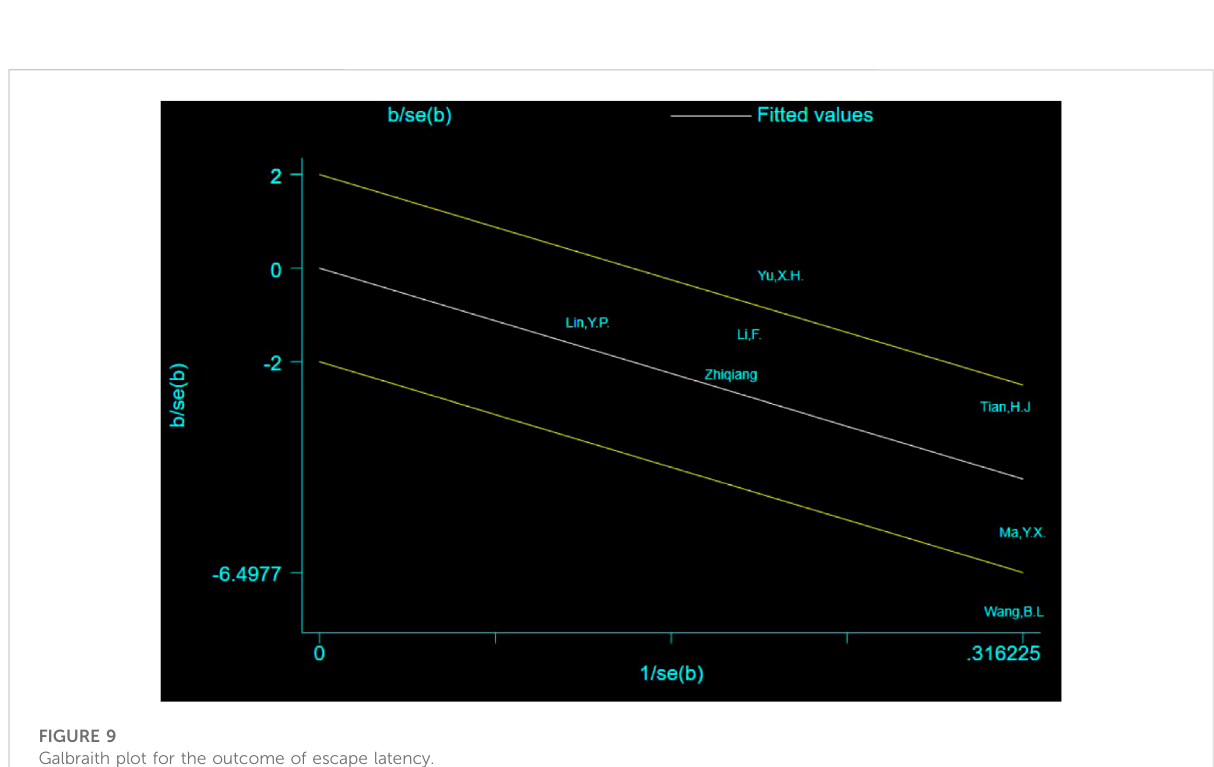
FIGURE 9 Galbraith plot for the outcome of escape